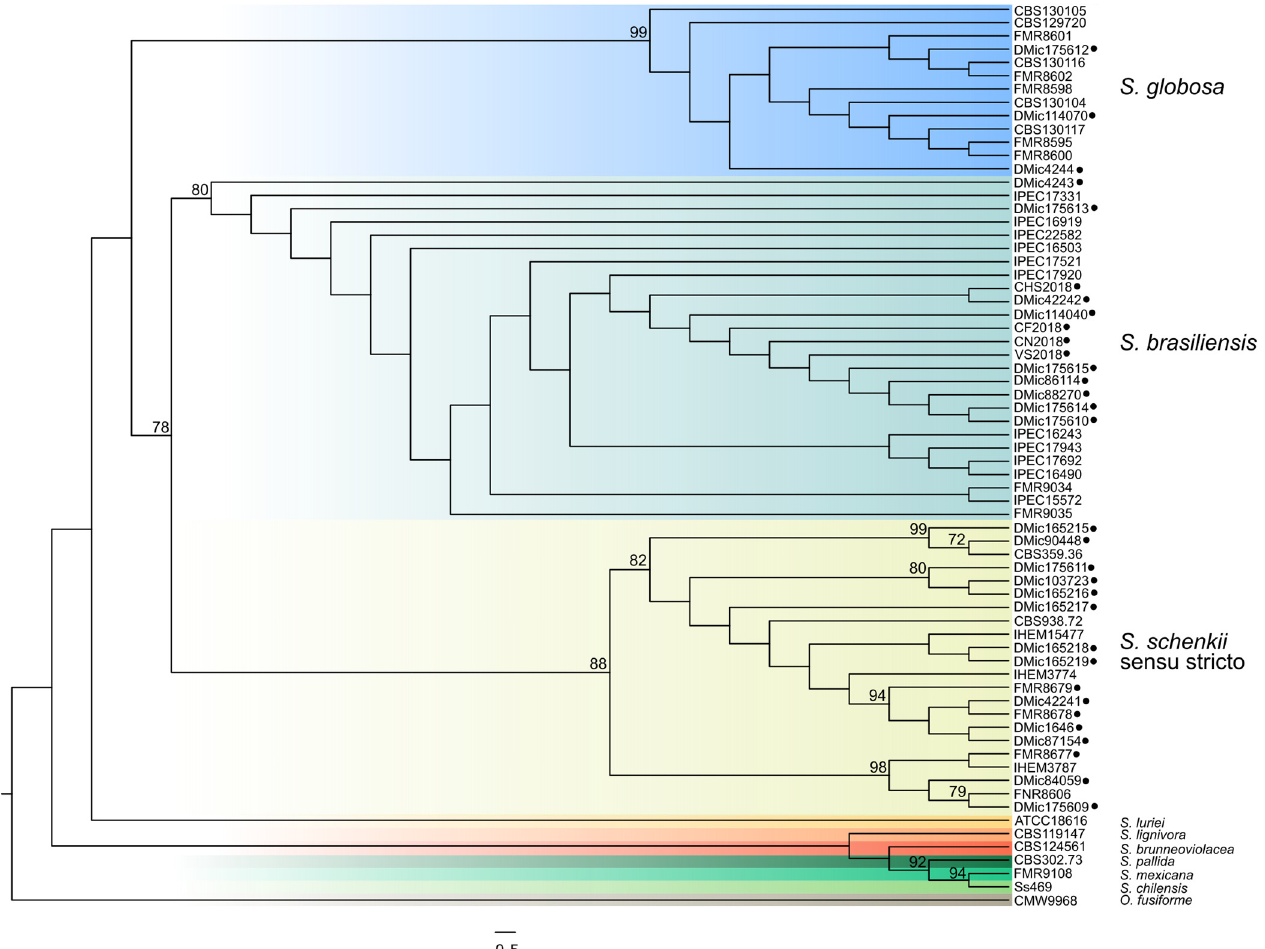
Figure 2. Phylogenetic tree generated from a maximum likelihood analysis based on the partial calmodulin sequence alignments of different Sporothrix spp. strains, including those from Argentina (black circles). The best model of evolution was estimated using the JModelTest software considering both the Bayesian and the Akaike information criteria and the phylogenetic tree was constructed using the PhyML 3.0 software. Clade stability was determined using a bootstrap resampling procedure with 1000 replicates. Gaps were treated as missing data. The nucleotide sequences of the corresponding genes of Ophiostoma fusiforme were used as outgroup.